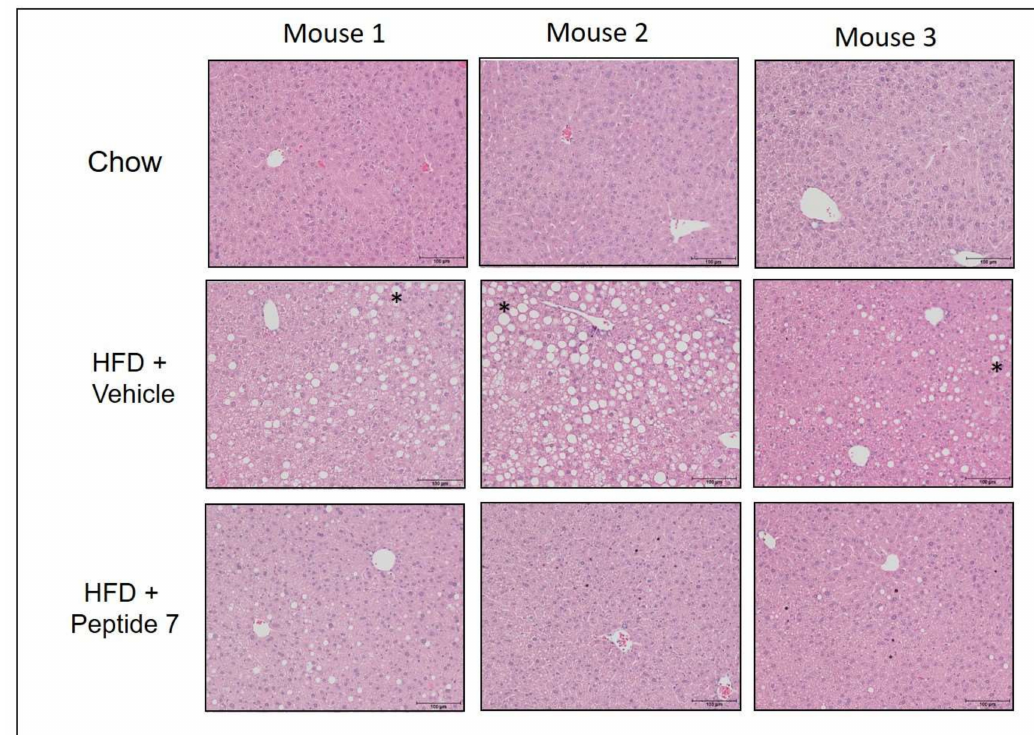
Figure 12. The TNFSF14 peptide, Peptide 7, reduces high fat diet-induced steatosis. Representative images are shown for n = 3 mice/group. * = steatotic